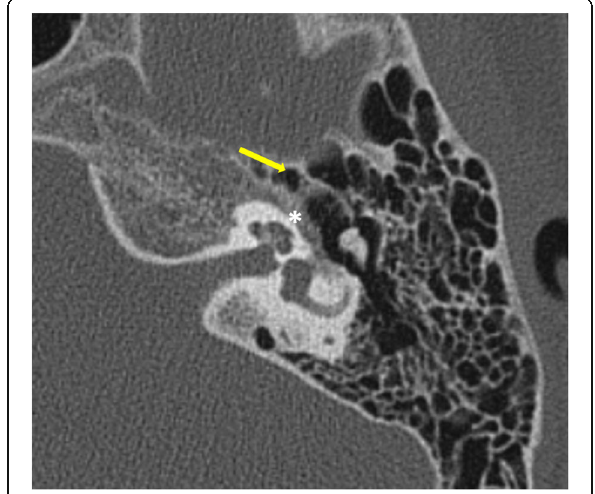
Fig. 6 Axial section through the epitympanum shows the normal anterior epitympanic recess (arrow) which is the medial extension of epitympanum. Its importance lies in its close proximity to the tympanic segment of the facial nerve canal